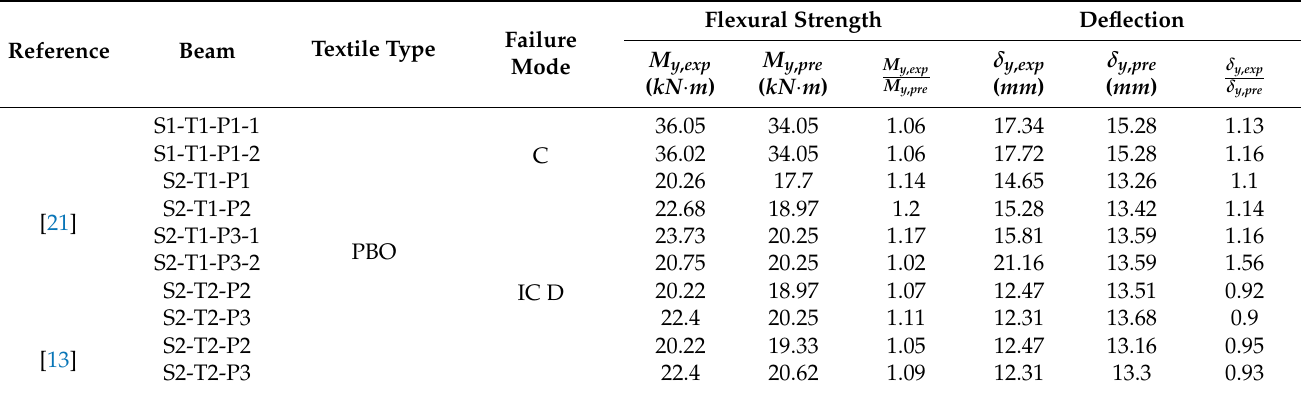
Table 8. Failure mode, flexural strength, and deflection of each